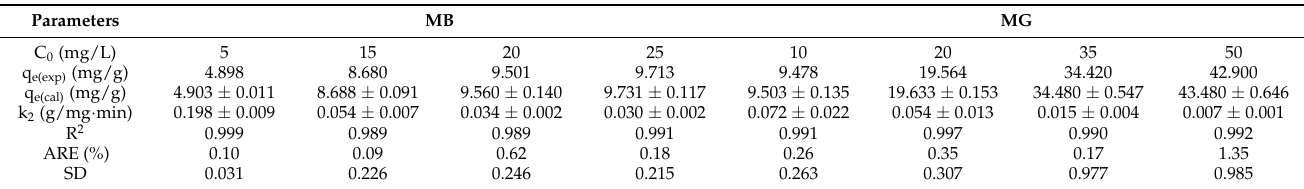
Table 2. Parameters for second-order kinetic model for removal of MB and MG dyes by 4AZW at 25 ◦ C using nonlinearized